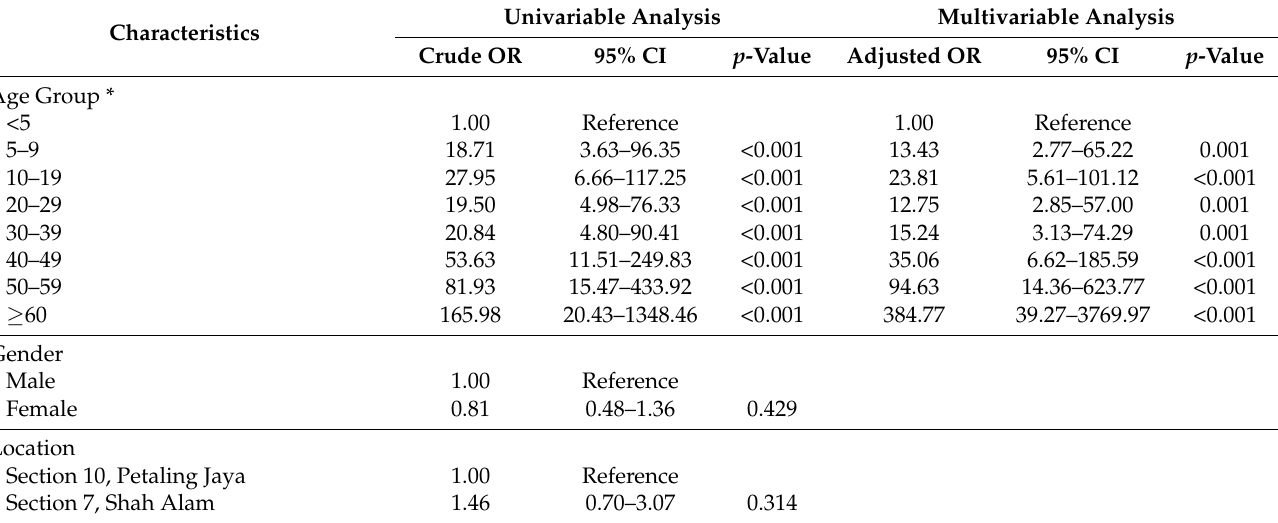
Table 2. Univariable and multivariable analyses of factors associated with DENV seropositivity ( n =